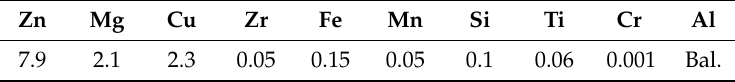
Table 1. Chemical composition of Al 7055 alloy, (mass fraction,